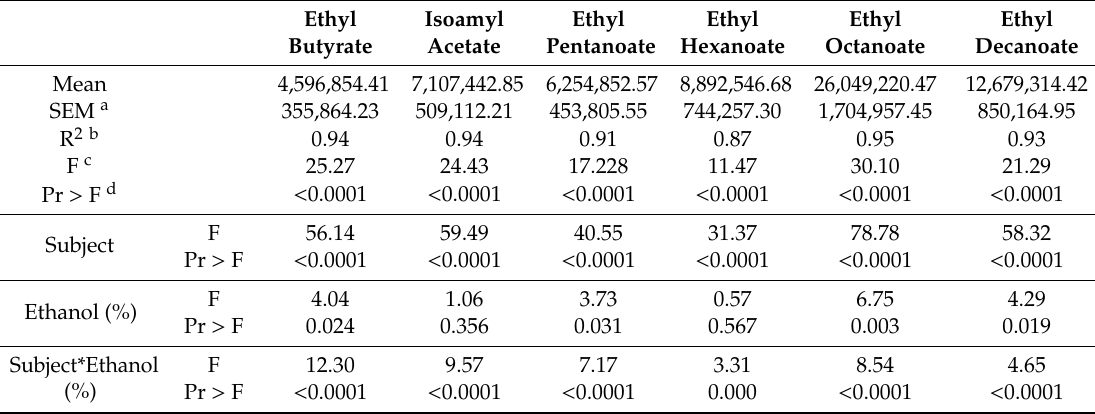
Table 2. Results of the two-way ANOVA performed to compare the statistical significance of the ethanol content on the immediate intra-oral aroma release (n = 10). Each sample was analyzed in